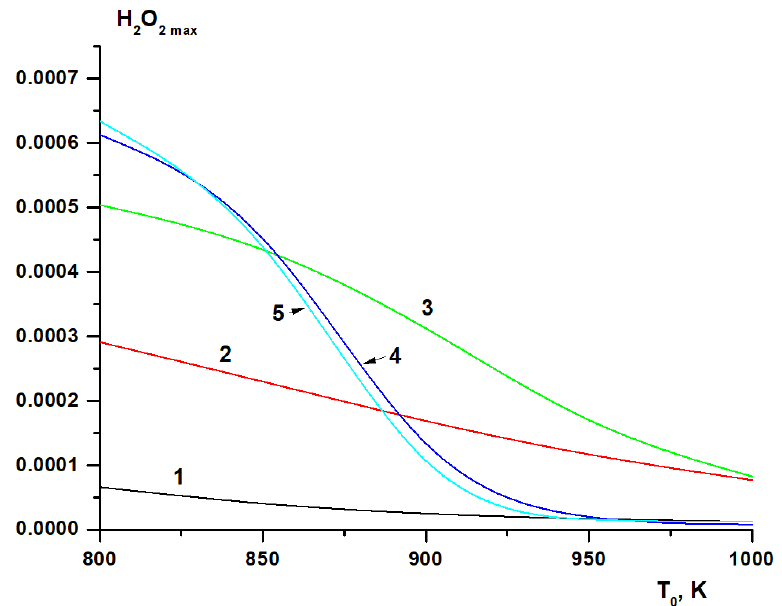
Figure 14. Calculated dependence of the maximum concentration of hydrogen peroxide (molar fractions) on the initial temperature at various hydrogen concentrations (%): 0 ( 1 ), 40 ( 2 ), 70 ( 3 ), 90 ( 4 ), 100 ( 5 ).